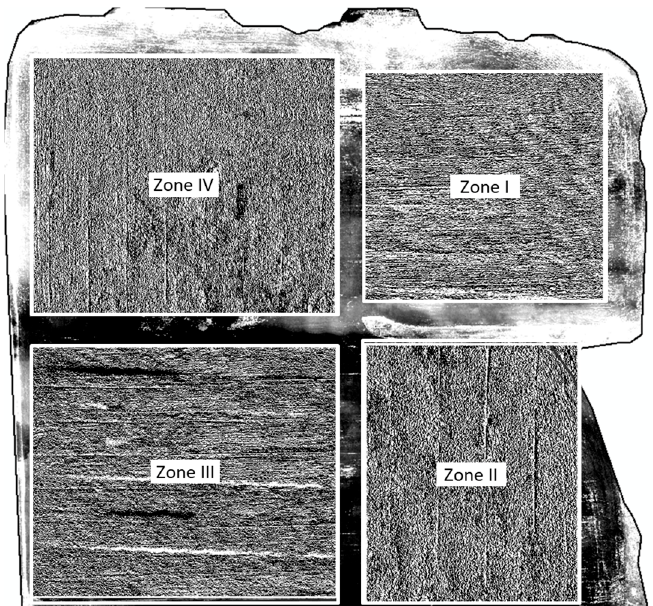
Figure 7. Enhanced thermal imageries showing tile lines in four sub-regions (zones) in the study site.